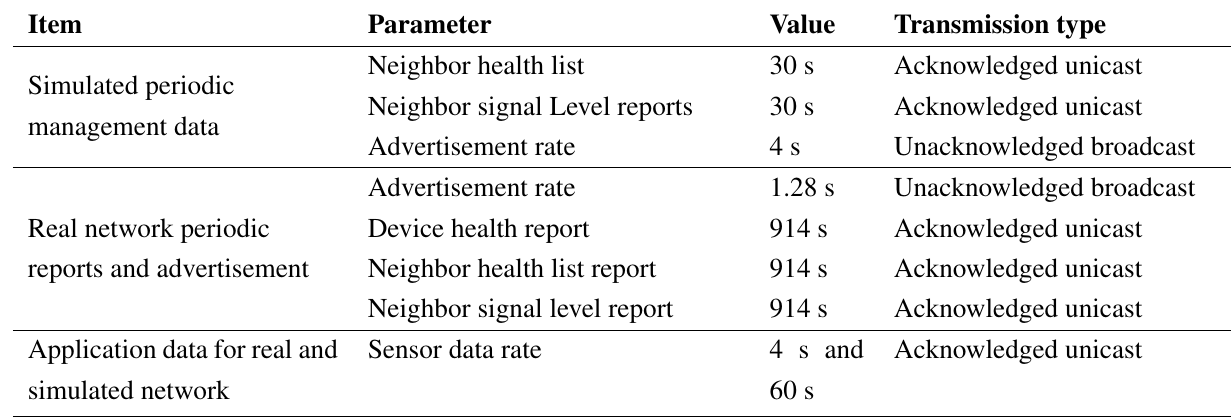
Table 3. Periodic messages rates. CBR: constant bit